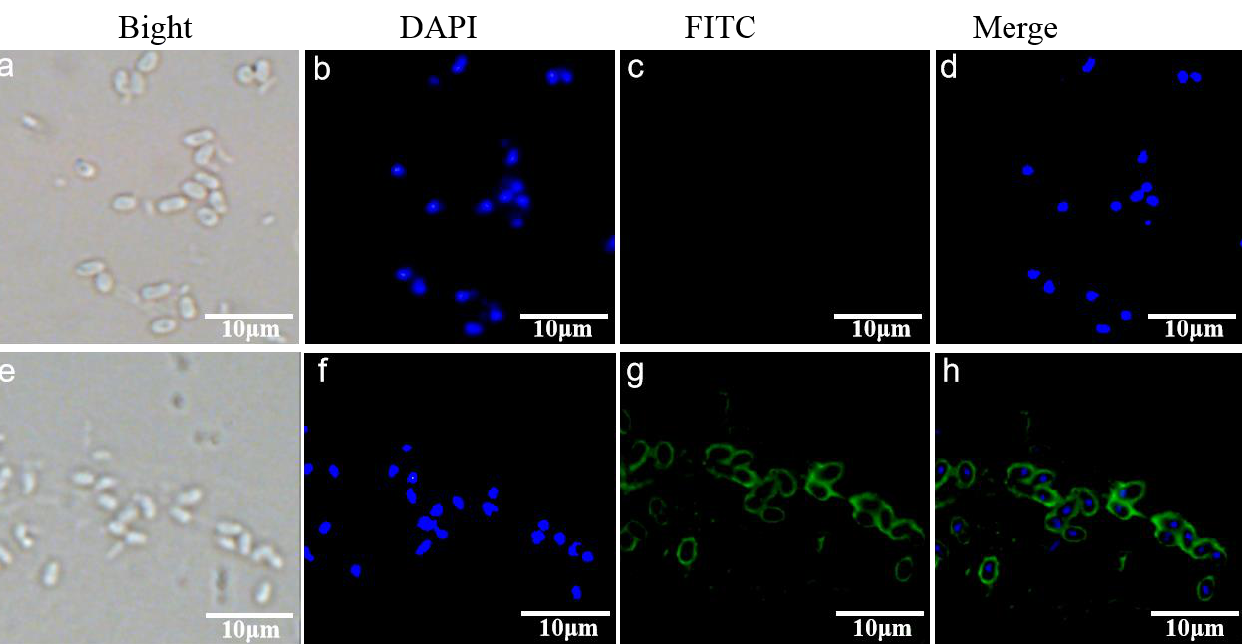
Figure 8. Immunofluorescence localization of EhSWP3 on the spore wall of purified Enterocytozoon hepatopenaei spores. Panel ( a – d ) normal rabbit serum. Panel ( e – h ): rabbit anti- EhSWP3 serum. ( d ) merged images of ( b , c , h ) merged images of ( f , g ). The blue fluorescence signal represents the nuclei of the spores.